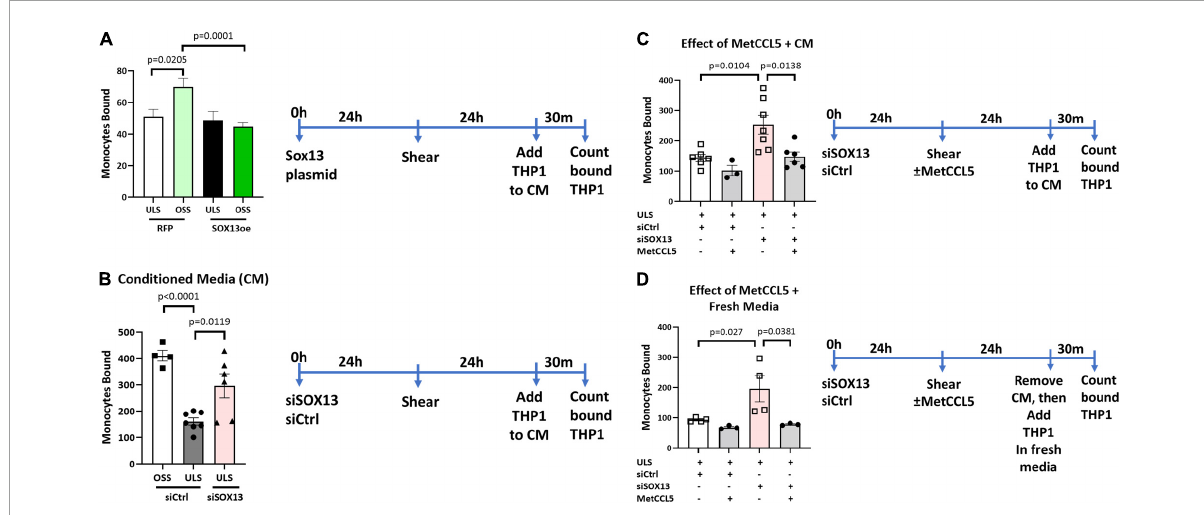
FIGURE8 Monocyte adhesion induced by siSOX13 is prevented by treating HAECs with MetCCL5. (A) HAECs overexpressing SOX13 or RFP control were exposed to OSS or ULS for another 24 h. Following shear, THP1 monocytes were added to the conditioned media (CM), and adhered monocytes were counted. (B) HAECs treated with siSOX13 or siCtrl were exposed to OSS or ULS for another 24 h. Following shear, THP1 monocytes were added to the CM, and adhered monocytes were counted. (C,D) HAECs treated with siSOX13 or siCtrl were exposed to OSS or ULS in the presence or absence of MetCCL5 for another 24 h. Following shear, THP1 monocytes were added to the CM, and adhered monocytes were counted (C) . In panel (D) , following shear, CM was removed, HAECs were washed with fresh medium, THP1 monocytes were added to the CM, and adhered monocytes were counted. Mean ± SEM are shown, n = 3 to 7, p -values determined by one-way